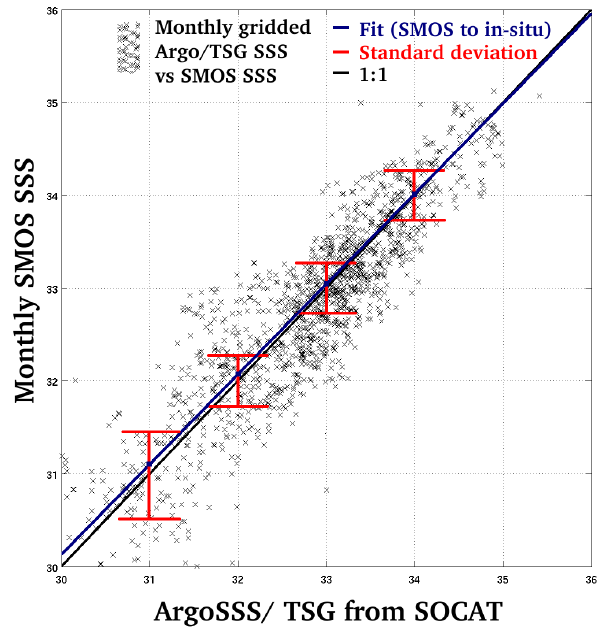
Figure A1. A comparison of in situ salinity measurements (from ship-mounted thermosalinograph or Argo) and correspond- ing SMOS salinity measurements made within the ETPO between July 2010 and December 2014. The fit and 1:1 relationships are indicated by the blue and black lines, and the error bars indicate the standard deviation between the two measurements for each 1psu salinity